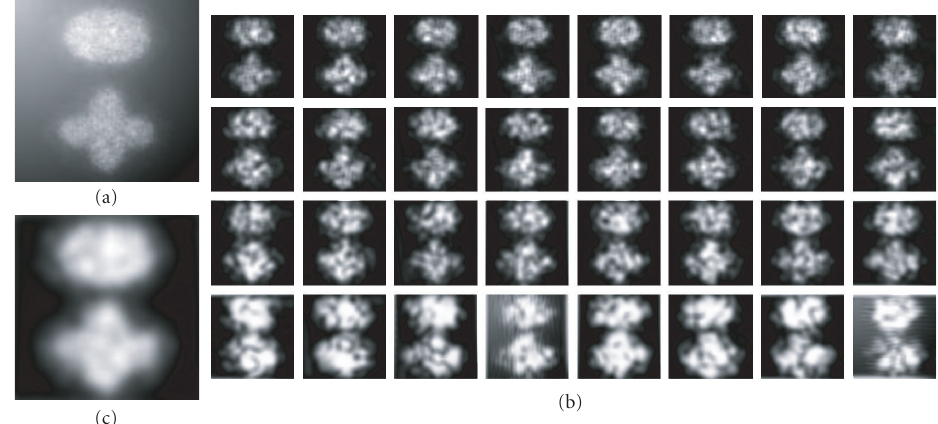
Figure 2: Illustration of the texture feature characterization: (a) original image with the intensity inhomogeneity; (b) texture energy bank illustration; (c) texture feature